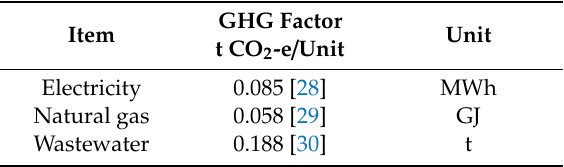
Table 2. Environmental impact coe ffi